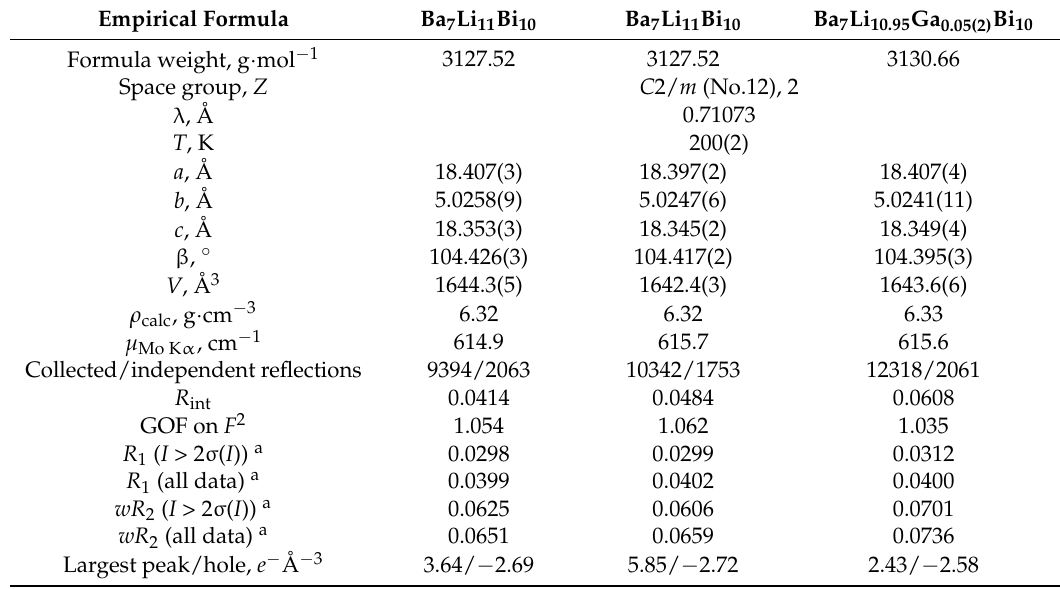
Table 5. Selected crystal structure data refinement parameters for Ba 7 Li 11 Bi 10